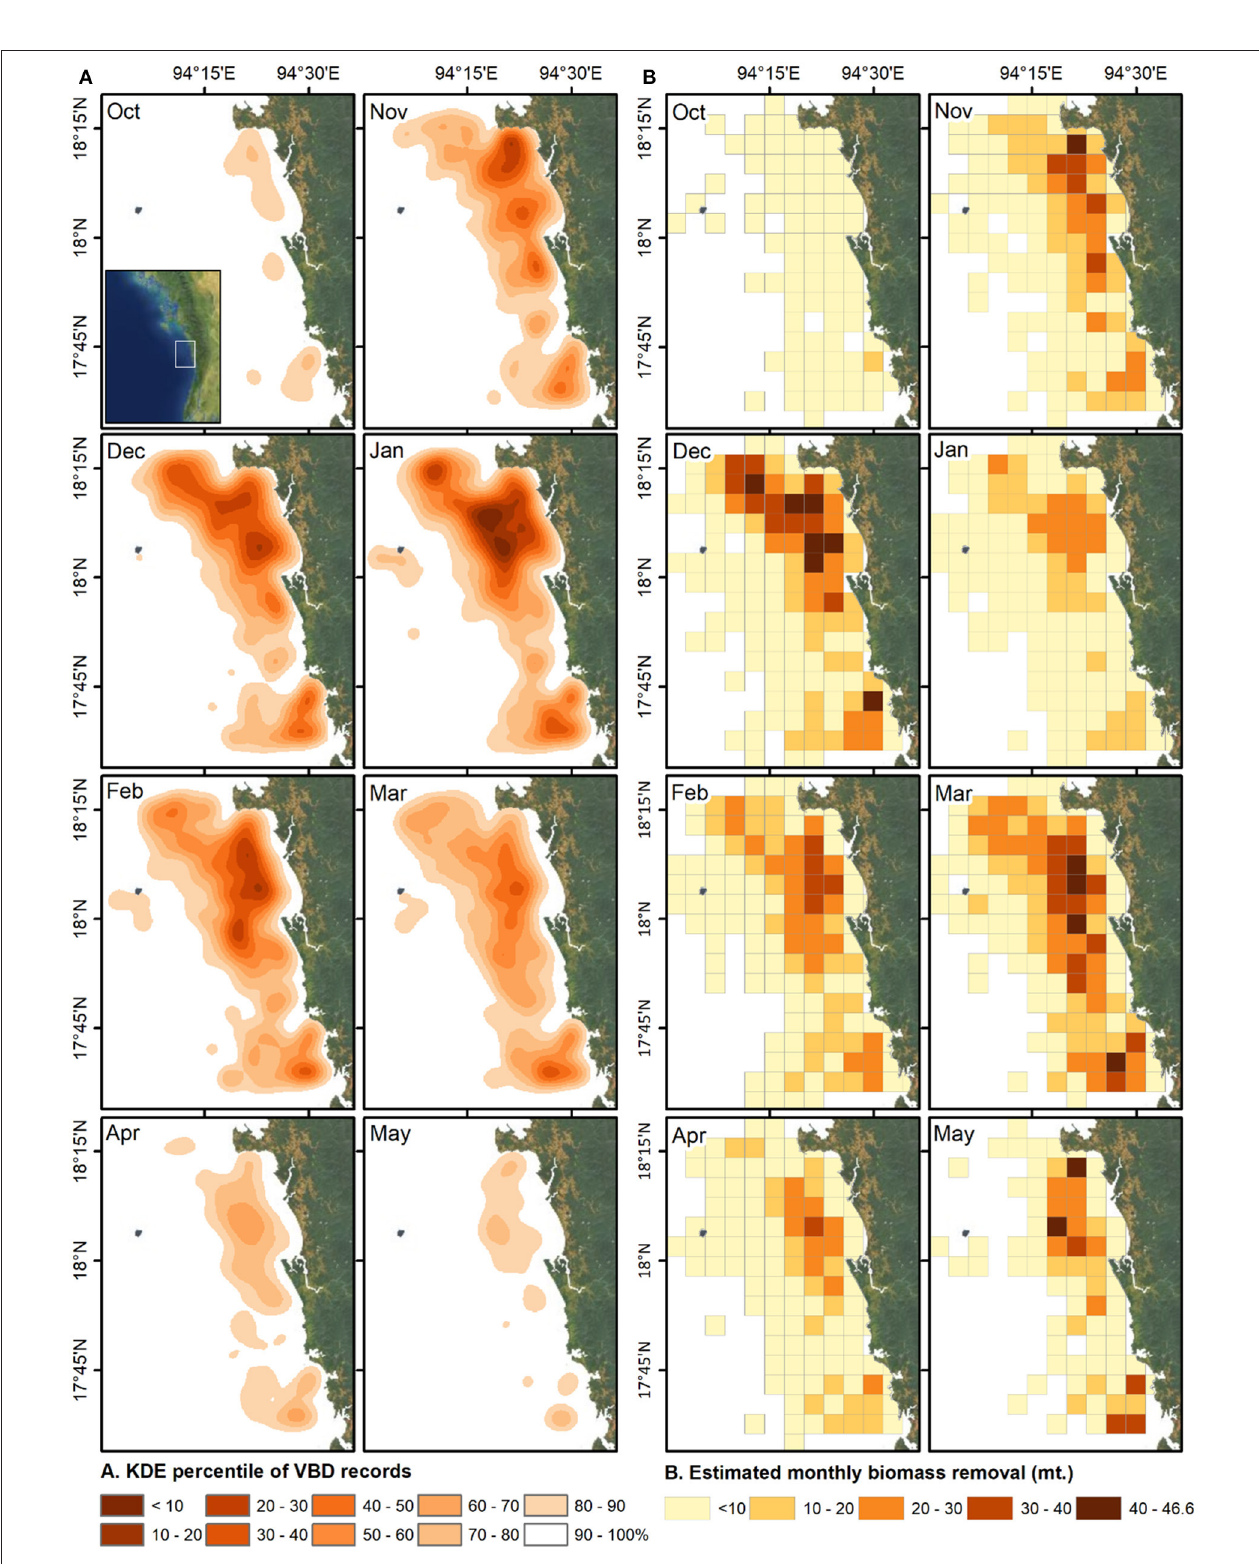
FIGURE 5 | Monthly spatial fishing effort and biomass extraction. (A) KDEs show monthly VBD detections using 250 × 250m grid cells with a 5 km search radius (October to May 2016–2019). (B) Estimates using a monthly mean of VBD records, corrected by monthly match rates and multiplied by mean monthly catch per haul (kg) to estimate biomass removal at 5 × 5 km grid cell